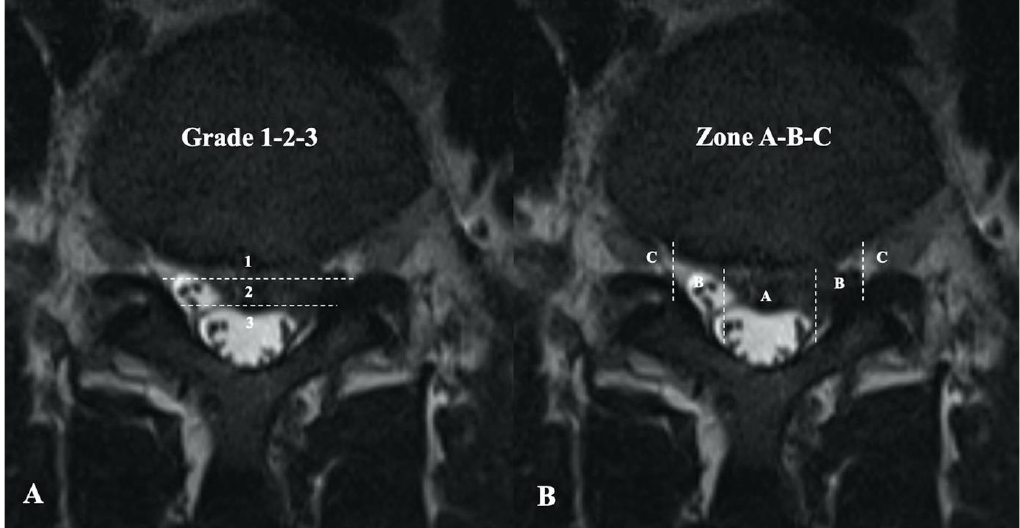
Figure 1. Michigan State University classification of herniated lumbar discs on magnetic resonance imaging. ( A ) Grading of disc herniation according to size. Grade 1 lesions have minimal impact and grade 3 have the most significant effect on nerve compression. ( B ) Zoning of the disc to identify location. Lesions in tighter zones (B and C) had more impact.